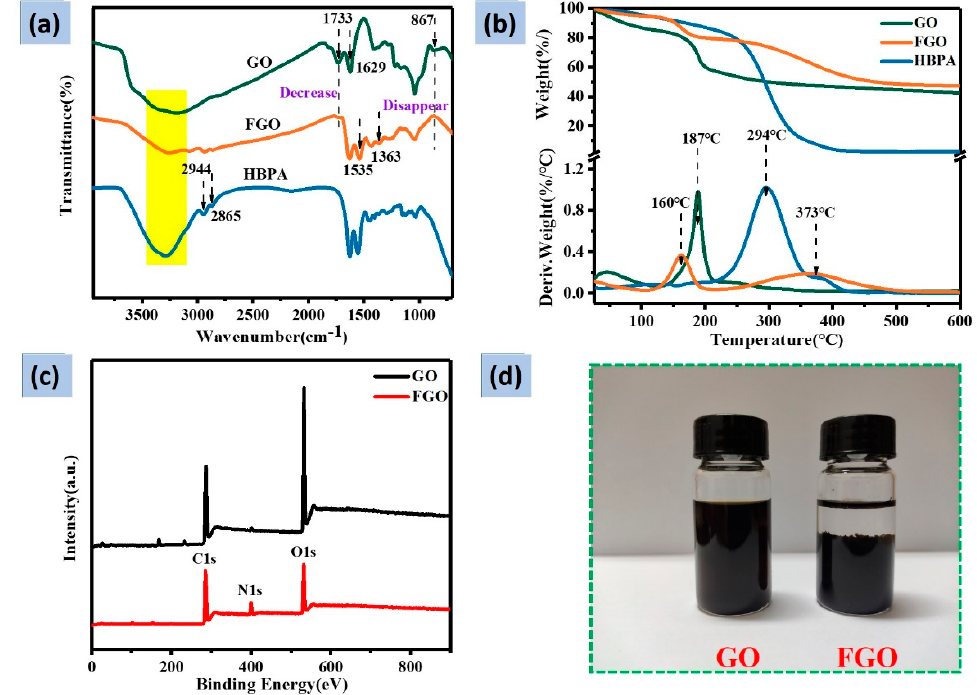
Figure 2. ( a ) FTIR spectra of GO, FGO, and HBPA; ( b ) TG and DTG curves of GO, FGO and HBPA; ( c ) XPS of GO and FGO; ( d ) Aqueous Solutions of GO and FGO.